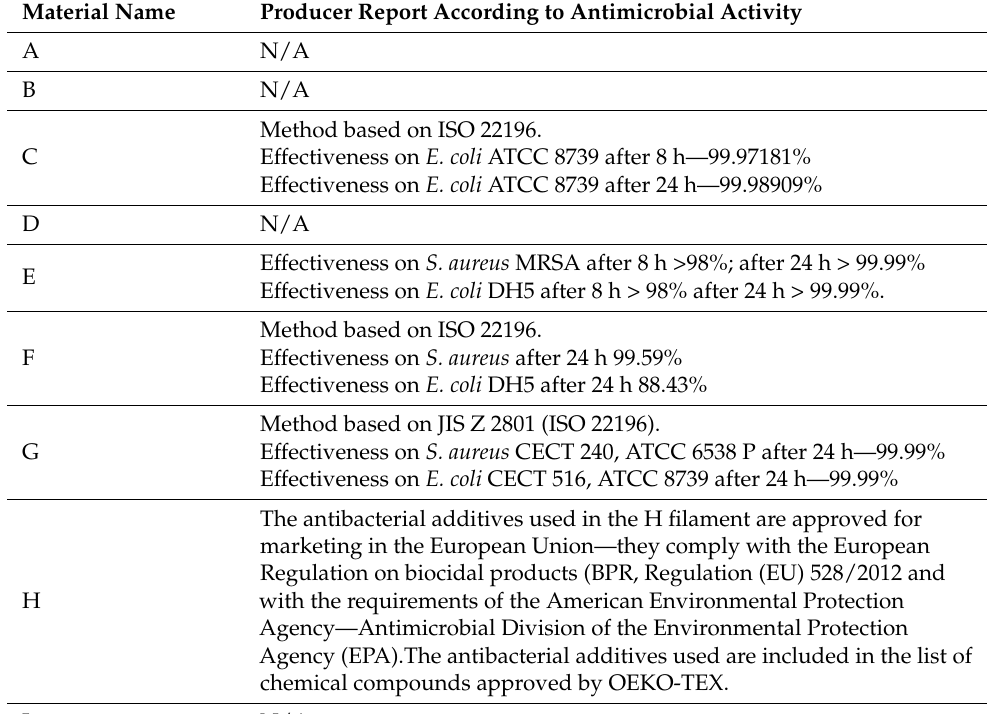
A–I: specific type of material